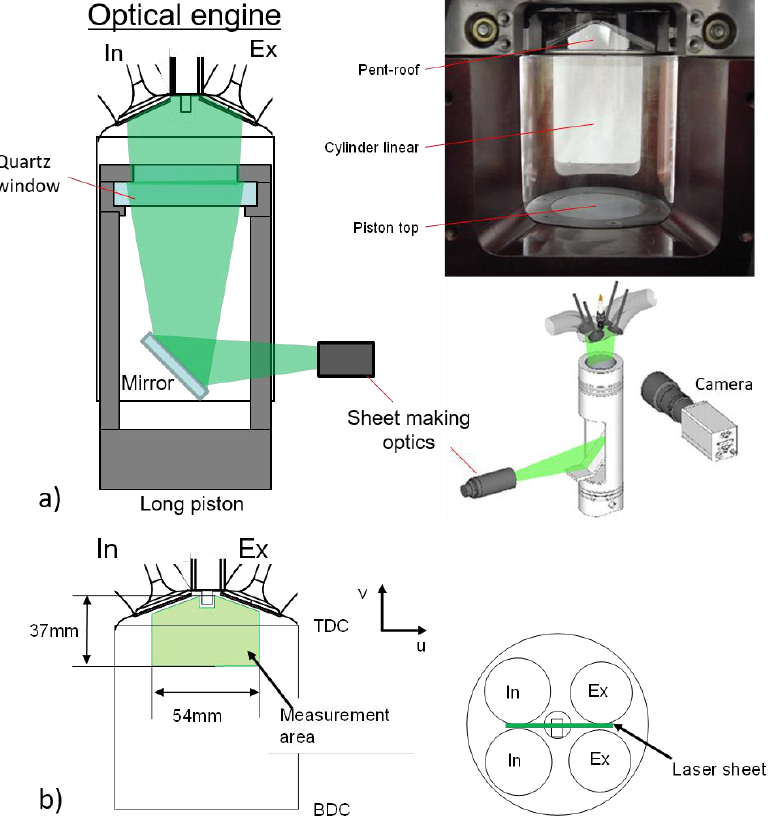
Figure 2. ( a ) Optical engine and Particle Image Velocimetry (PIV) set up, ( b ) PIV measurement area and position of the laser sheet with respect to the cylinder.